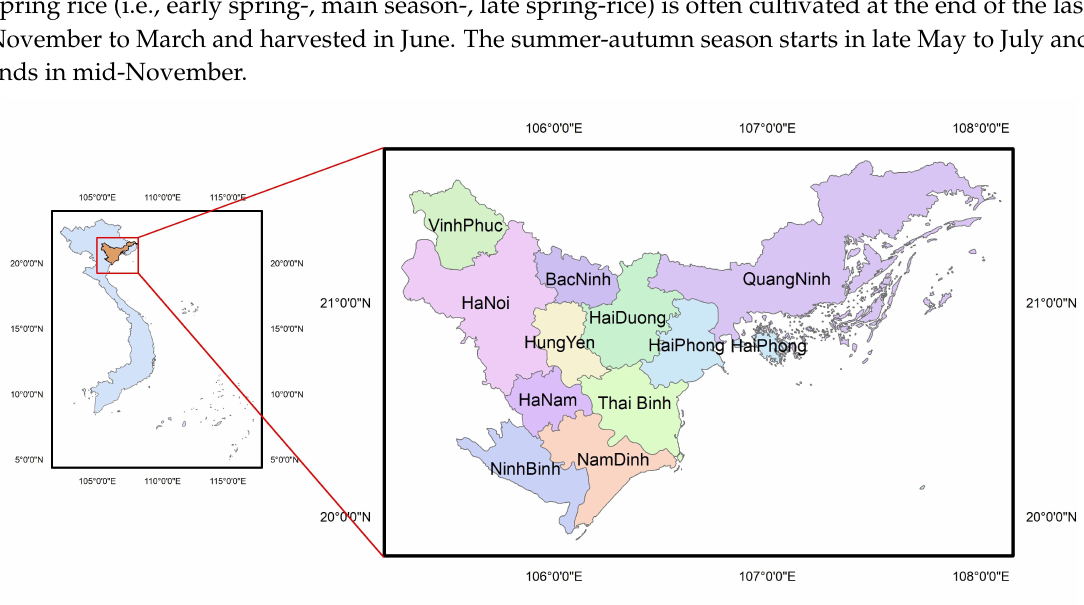
Figure 1. Administrative map of the Red River Delta over